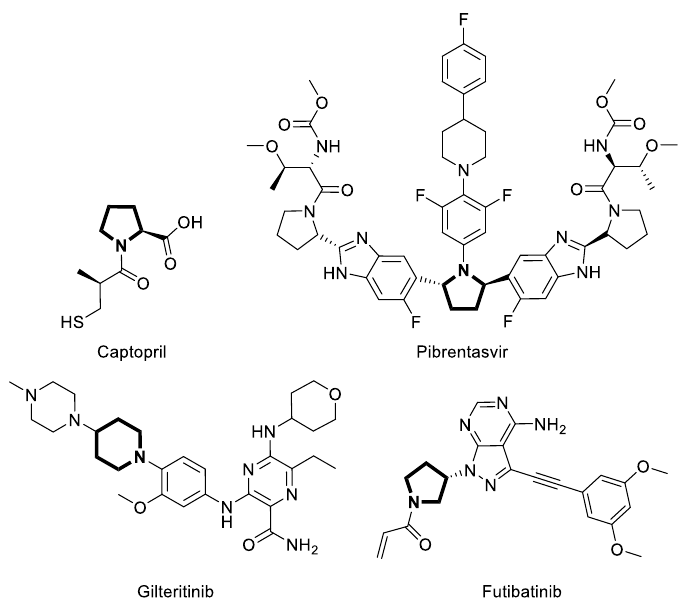
Figure 1. Several drugs bearing the azacycle